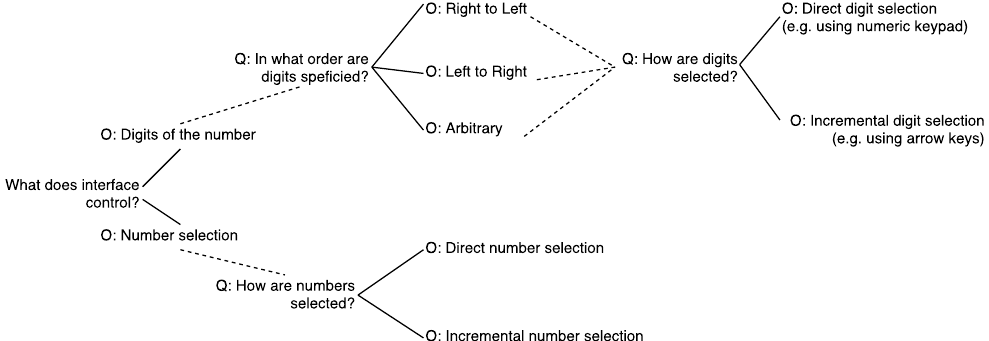
Figure 1: The QOC analysis segments the design space of number entry systems into two main dimensions. Some interfaces allow the explicit specification of digits in a number, while others allow selection of a number from a list of valid values. Digit based interfaces are further distinguished based on the order of digit specification and how digits are selected (e.g., direct selection or incremental selection), while number selection based interfaces are structured based on how numbers are selected (e.g., direct selection or incremental